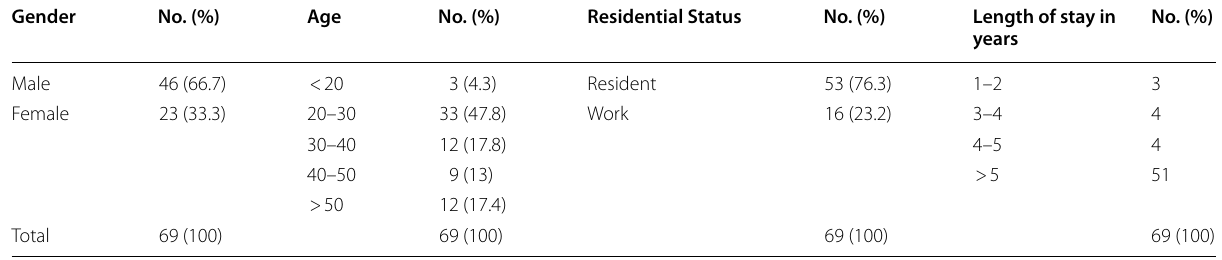
Table 1 Respondents background information by gender, age group, residential Status, and Length of stay in the area